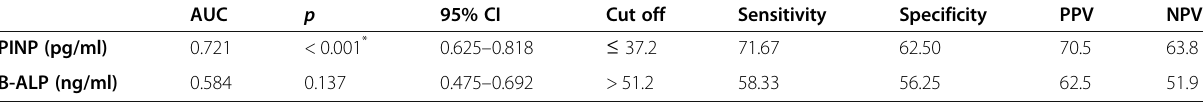
Table 6 Agreement (sensitivity, specificity) for PINP and B-ALP to discriminate osteoporosis patients ( n = 60) from osteopenia patients ( n = 48) AUC p 95% CI Cut off Sensitivity Specificity PPV NPV PINP (pg/ml) 0.721 < 0.001 * 0.625 – 0.818 B-ALP (ng/ml) 0.584